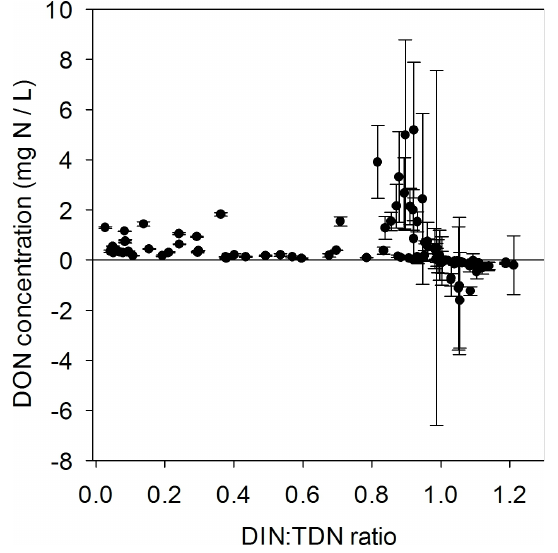
Fig. 1. Mean ± 1SD of DON concentrations versus the DIN:TDN ratio measured by the standard approach (HTCO-TDN minus DIN) for the screening of 99 streams and rivers draining northeast- ern German catchments. Means and uncertainties were determined by MC simulations for the standard approach with 3 measure- ment replicates for HTCO-TDN and 2 measurement replicates for NO − +NO − and NH + . 3 2 4